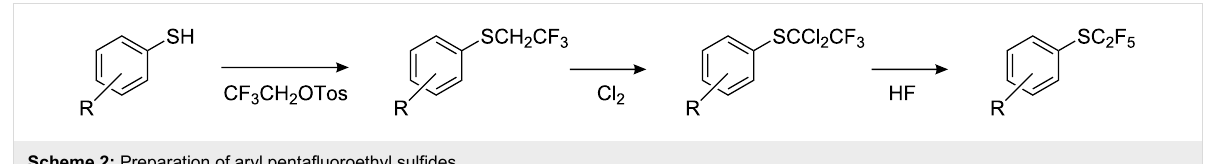
Scheme 2: Preparation of aryl pentafluoroethyl